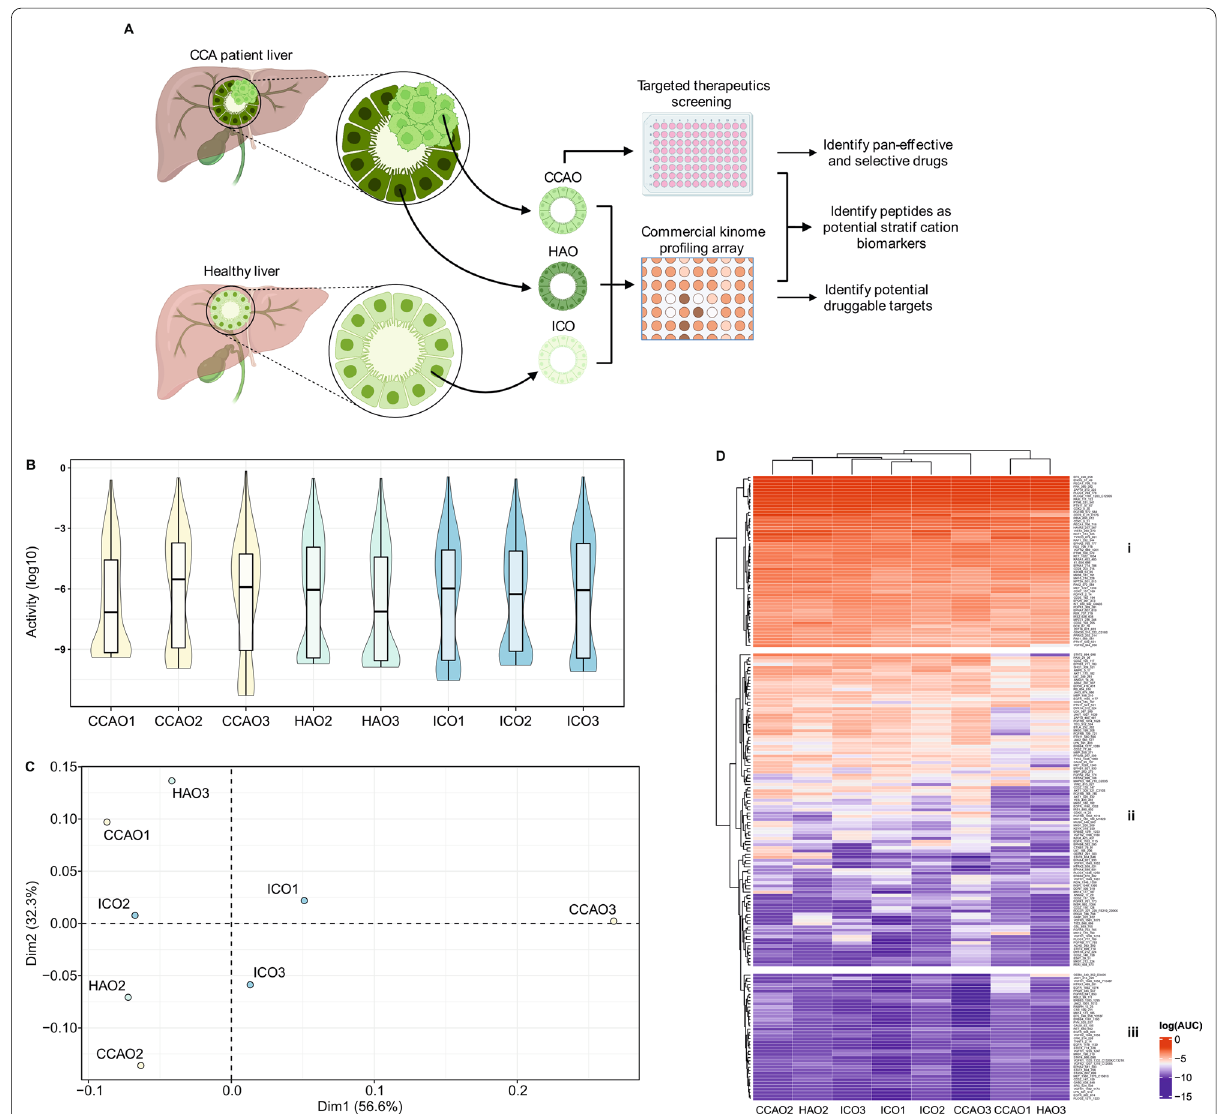
Fig. 2 Exploratory kinome analysis demonstrates individual kinase activity profiles of CCAOs. A Schematic representation of the experimental setup. Kinase activity profiles were established for three CCAO lines with two matched non-tumorous adjacent tissue-derived organoid lines (CCAO1, CCAO2 with matched HAO2, and CCAO3 matched with HAO3) and three healthy donor-derived intrahepatic cholangiocyte organoid lines (ICO1, ICO2 and ICO3). Comparison of these profiles leads to the identification of potential druggable targets. CCAOs were also subjected to a screening of targeted therapeutics to identify pan-effective and selective compounds. Correlation between drug response and kinase activity leads to the discovery of potential biomarkers for treatment stratification. Schematic created with BioRender.com. B Violin plots with box plots showing that the overall kinase activity data density distribution is similar for all samples. Colors represent sample types (CCAO in yellow, HAO in green, ICO in blue). There was a significant difference in values among samples (p-value 1.488e 03). C PCA plot of kinase activity of all peptides included = − in the kinome profiling array based on principle component 1 and 2. Each sample is represented by one dot (CCAO in yellow, HAO in green, ICO in blue). CCAO3 is the most distinct sample in the dataset. CCAOs are positioned far apart. D Heatmap of all kinase target peptides on the array analyzed by unsupervised clustering for samples and for kinase target peptides. Data is shown by log10(AUC target peptide). Three peptide clusters are emphasized: (i) peptides highly phosphorylated in all samples, (ii) peptides with heterogeneous phosphorylation patterns between samples, and (iii) peptides lowly/not phosphorylated in all